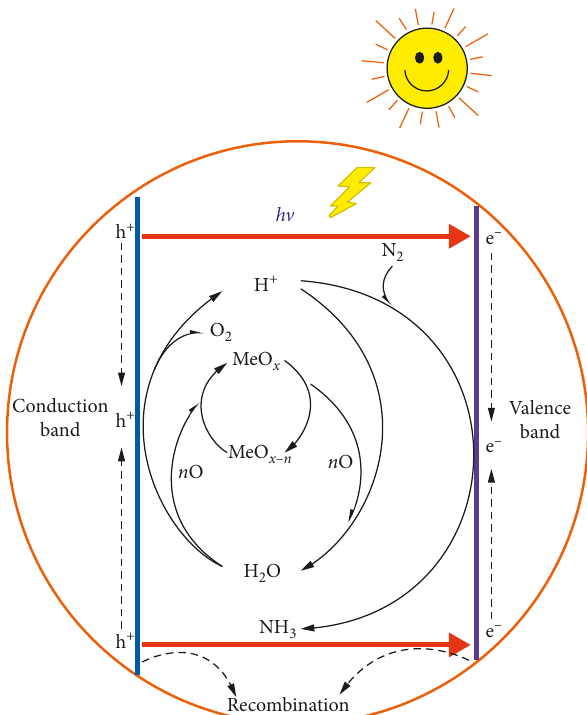
Figure 1: Schematic of metal oxide-based photocatalysts for re- ducing N 2 to NH 3 . MeO x (MeO x photocatalysts and Me denotes metals. Table 1: Redox potentials of reducing N